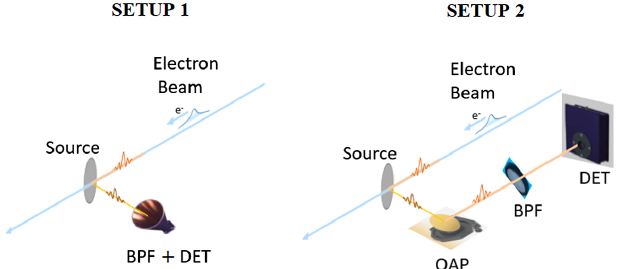
FIG. 2. Setup 1: the electron beam e − (blue line) passes trough the radiator, then the radiation (orange line) is reflected back to the detector (DET), a Schottky diode coupled to a waveguide BPF plus a gain-horn. Prewave zone measurements are possible. The angular scan of the p-polarization is made. Setup 2: the electron beam e − (blue line) passes trough the radiator, then the radiation (orange line) is collected/focused by an off-axis- parabola (OAP), it is filtered by means of a band-pass-filter (BPF), finally reaches the detector (DET), in this case a THz camera. Both far-field and near-field measurements are possible, adjusting the relative position between the parabola and the camera and/or the relative distance between the parabola and the